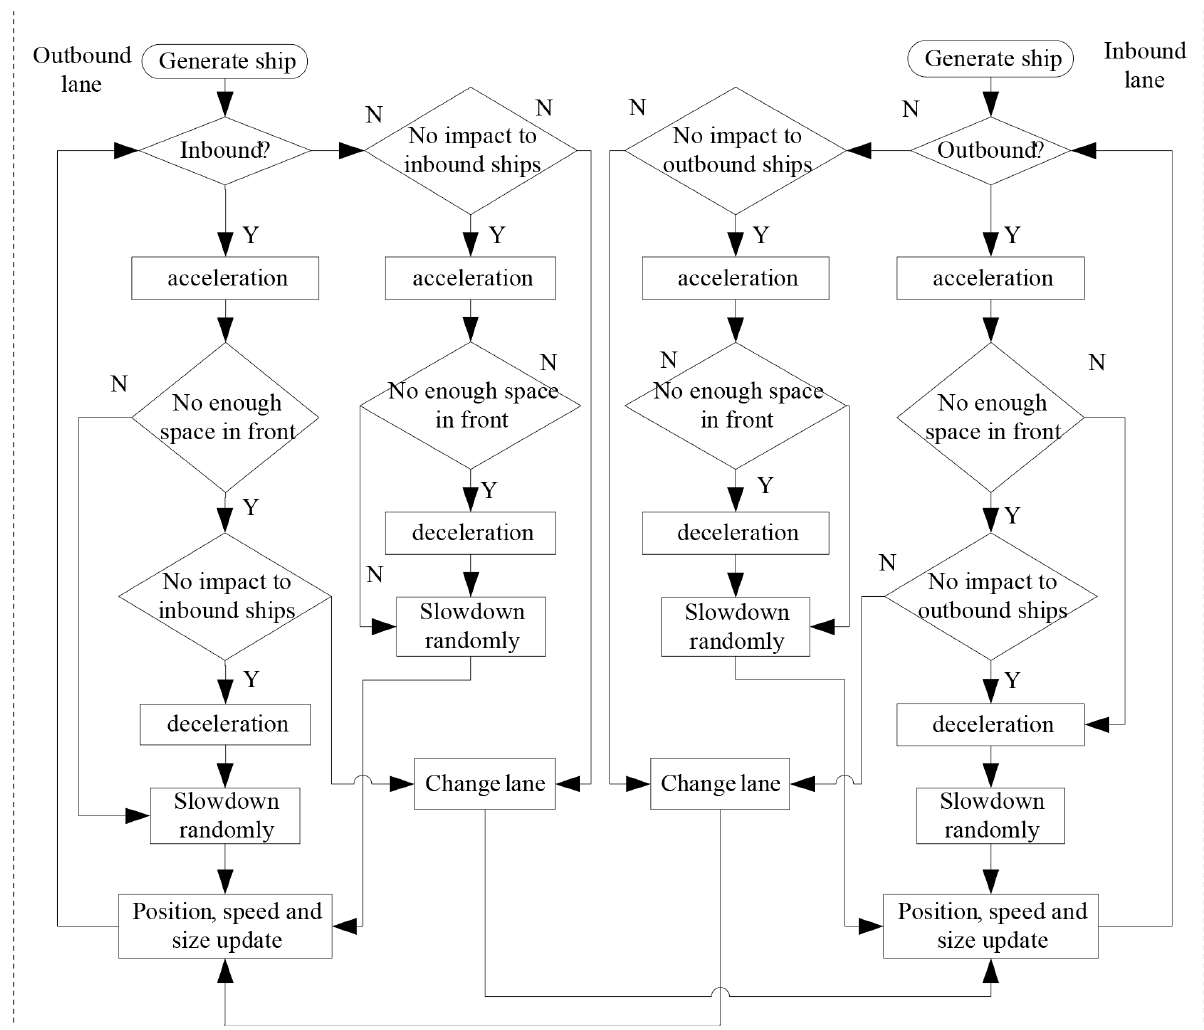
Figure 3. Cellular automata model for variable two-way waterway on